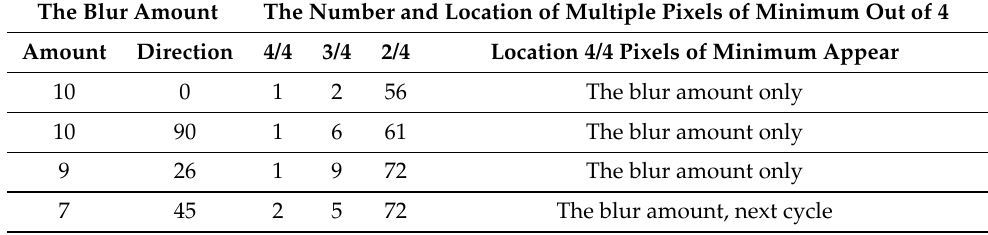
Table 13. Sun of different components; The number of the pixels and their locations where multiple pixels of minimum appeared out of four sub-images out of area A and B. The Blur Amount The Number and Location of Multiple Pixels of Minimum Out of 4